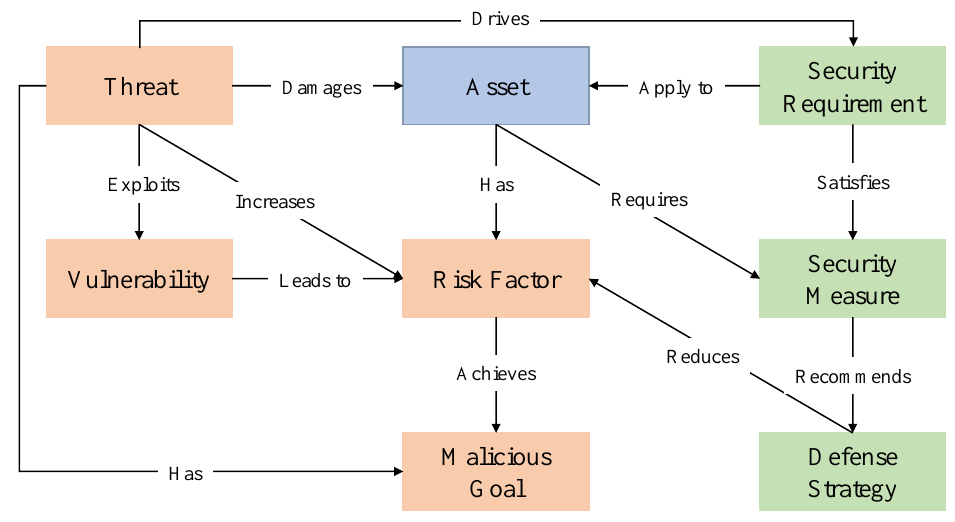
Figure 2. The diagram of AG-PDO compositions and